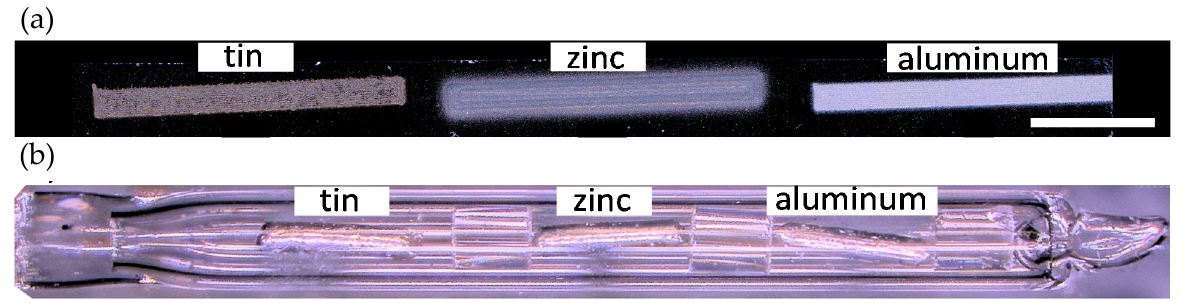
Figure 1. Additively manufactured and classical melt wire capsules. Prototypes of ( a ) AM melt wires of aluminum, zinc and tin fabricated by aerosol jet printing on an SiO 2 /Si substrate, and ( b ) a classical melt wire capsule containing aluminum, zinc and tin. For testing, both AM and classical melt wires were contained within quartz capsules with a helium atmosphere at ambient pressure. Scale bars represent 1 mm.